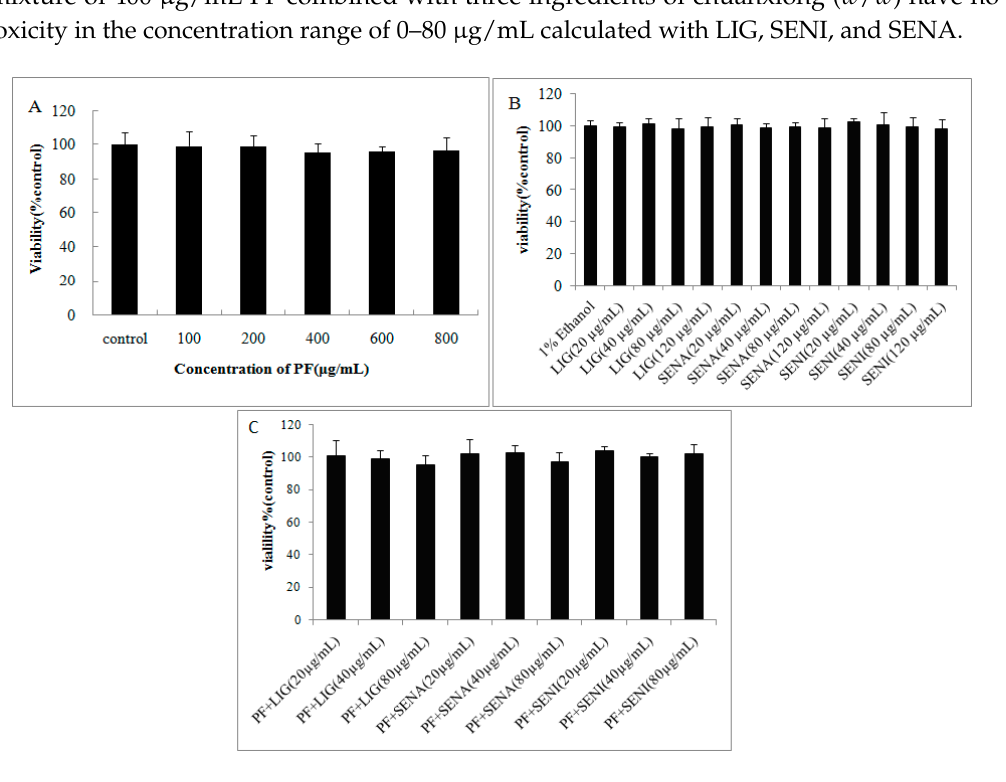
Figure 2. Cytotoxicity of paeoniflorin (PF) and its combination determined by 3-(4,5-dimethylthiazol- 2-yl)-2,5-diphenyltetrazolium bromide (MTT) test on MDCK-MDR1 cells: ( A ) cytotoxicity of PF; ( B ) cytotoxicity of LIG, SENI and SENA; and ( C ) cytotoxicity of 400 µg/mL PF combined with LIG, SENI and SENA. Date are expressed as mean ˘ standard deviation (SD) ( n =